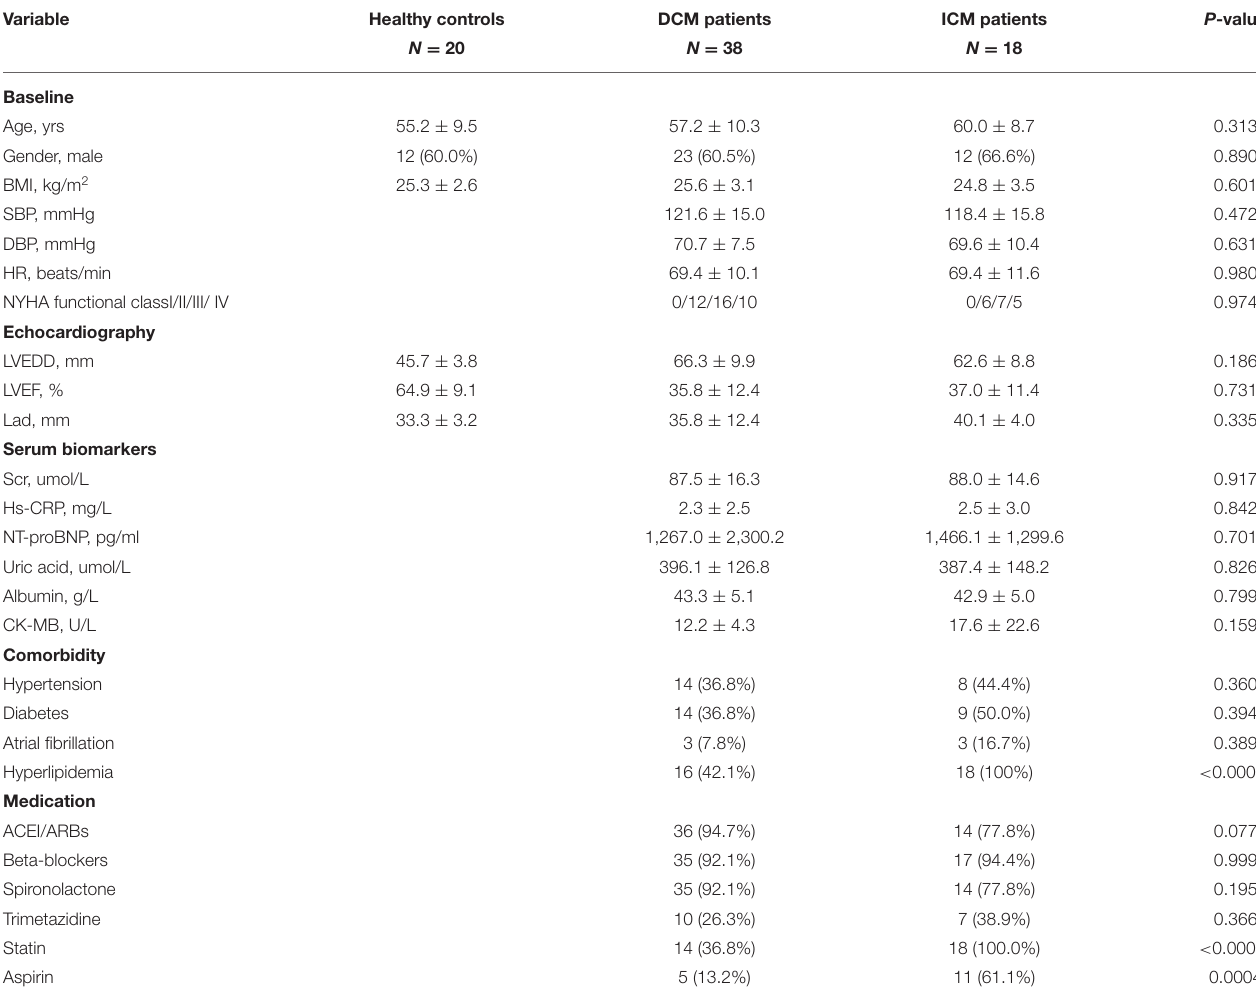
TABLE 1 | Clinical characteristics of DCM and ICM